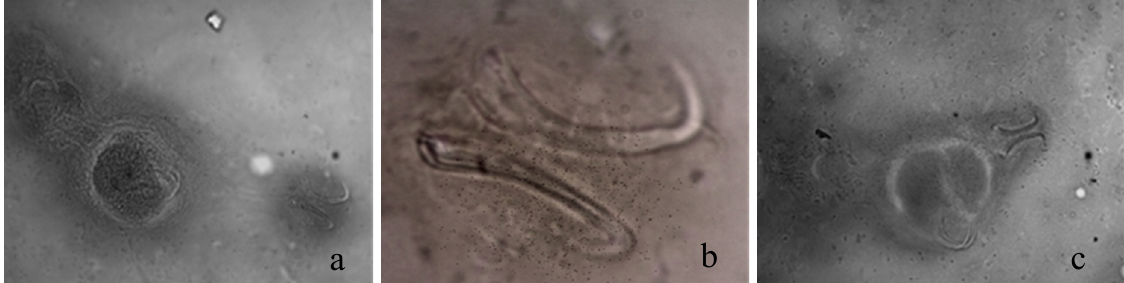
Figure 2. Morphological structure of Gyrodactylus sp. a. Adult stage, b. Adult with embryo, c. Hamuli.